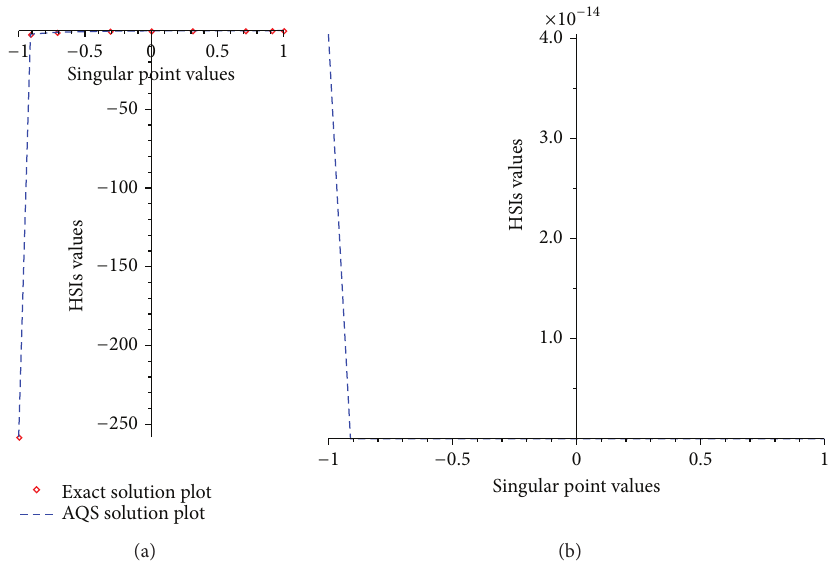
Figure 5: (a) Exact and AQS solutions when 𝑁 = 40 and ℎ(𝑡) = 1/(2 + 𝑡) and (b) absolute error between exact and AQS solution when 𝑁 = 40 and ℎ(𝑡) = 1/(2 + 𝑡)